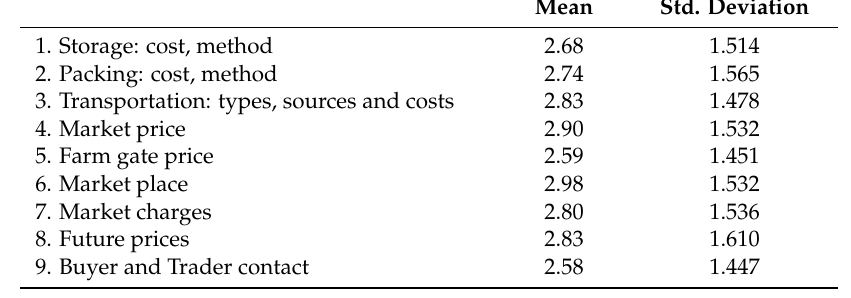
Table A2. Descriptive statistics of farmers’ access to different types of marketing information.